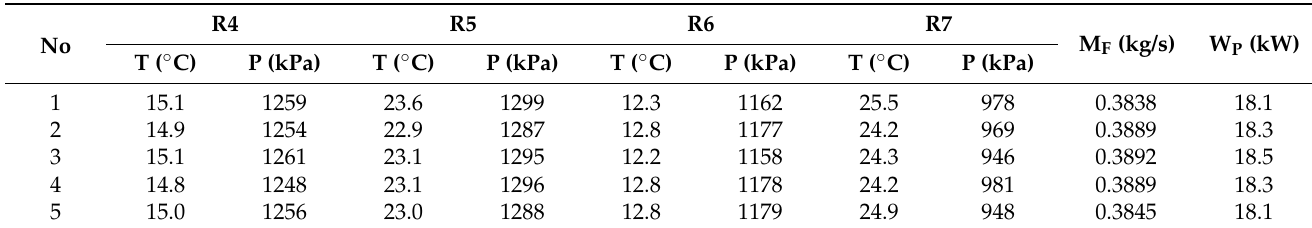
Table 20. Refrigerant side measurement result (five times).